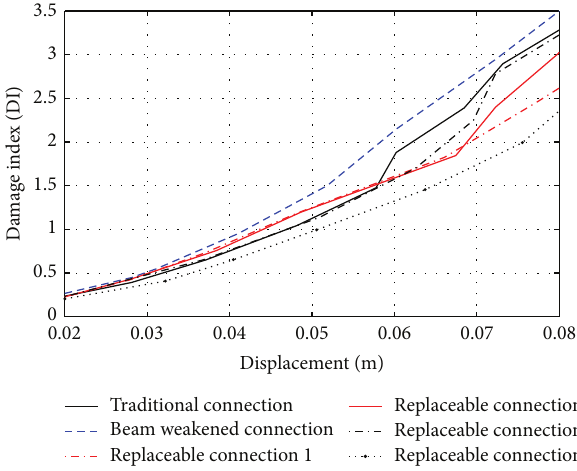
Figure 13: Damage index of different connections.